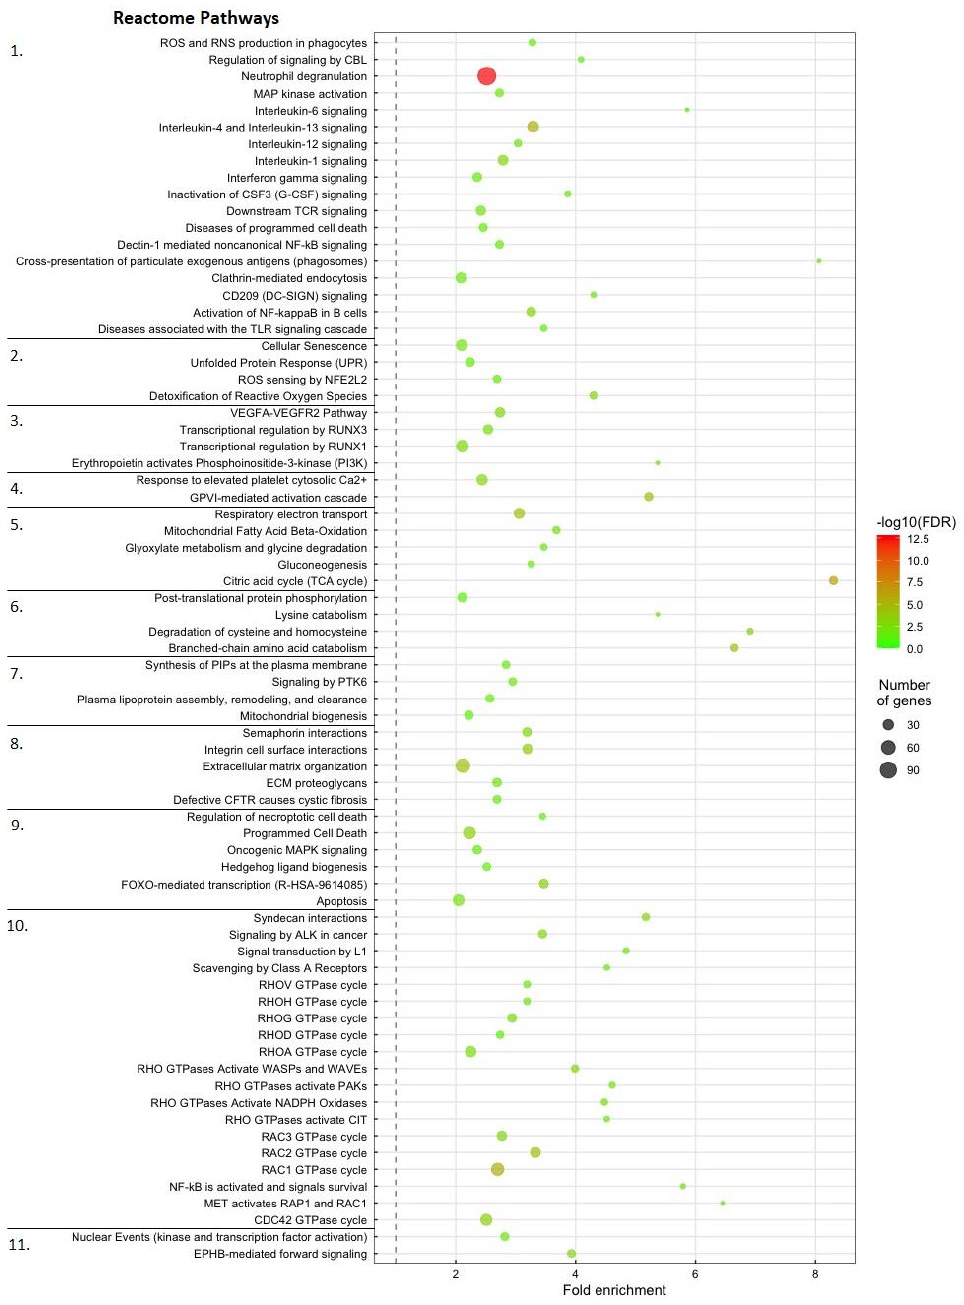
Figure 4. Enriched gene pathways associated with tDE-mRNA genes in lesion sites. The dot size indicates the number of tDE-mRNA genes associated with the process and the dot color indicates the significance of the enrichment (-log10 FDR-corrected p -values). The dot’s position on the Y-axis indicates fold-enrichment compared to the expected occurrence for a random set of genes of that size. The Reactome pathways were subdivided into the following categories indicated by the numbers on the far left: 1. Immune System. 2. Response to Stress. 3. Angiogenesis. 4. Platelet Activation. 5. Energy Metabolism. 6. Metabolism of Amino Acids. 7. Cell Maintenance. 8. Cell Communication. 9. Cell Cycle Control. 10. Receptor Signaling. 11. Neuronal Growth.